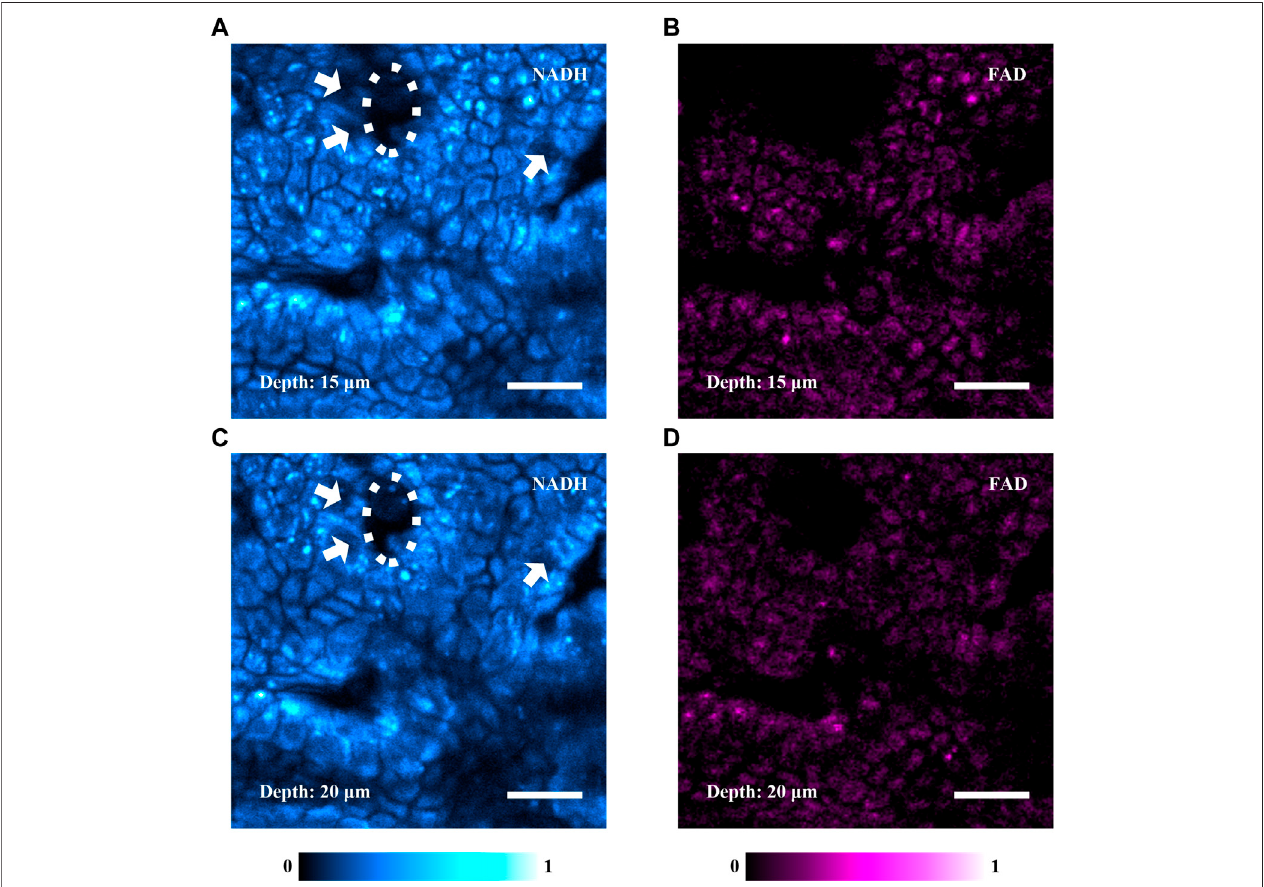
FIGURE 4 | Simultaneously acquired TPF images of NADH and FAD in mouse colonic mucosa, equivalent 20 μ s/pixel, 512 × 512 pixels. (A) A TPF image of NADH acquired at the depth of 15 μ m into the colonic mucosa. It shows that the colonic mucosa predominantly comprises colonocytes and crypts of Lieberkühn. The white arrows indicate a few cells, which are probably goblet cells. The white oval denotes a crypt. (B) A TPF image ofFAD simultaneously acquired at thesameregion of (A) in thecolonicmucosa. (C,D) TPFimagesofNADHandFADsimultaneouslyacquiredatthedepthof20 μ m.Thewhitearrowsin (C) indicatethesamecellsin (A) .The white oval in (C) denotes the same crypt in (A) . The scale bars are 20 μ